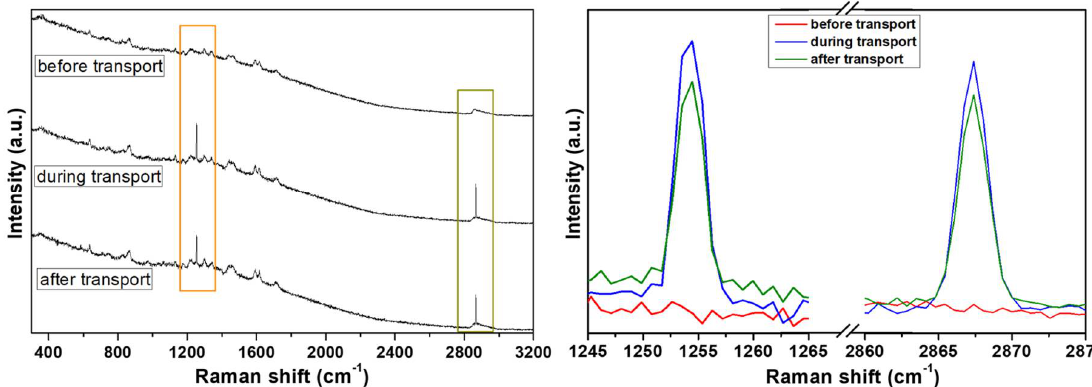
Figure 6. Raman spectra of CP36 in 0.1 M HCl before, during and after transport experiment: full range ( left site ) and onset of changed region ( right site ).